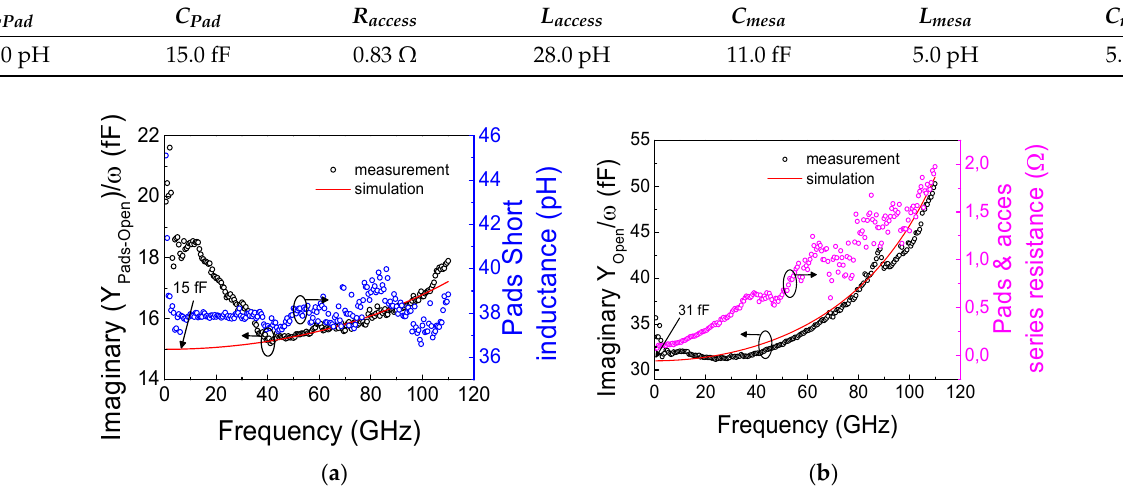
Figure 6. Extraction of parasitics equivalent for: ( a ) the Pad Open and the Pad Short ( b ) the mesa-free access lines.